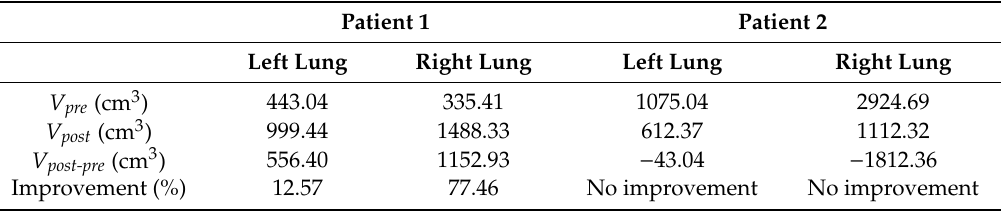
Figure 4. Perfusion SPECT images pre-treatment (left) and post-treatment (right). The contour of the segmentation is drawn in green in the images and the color bar. ( a ) Patient 1 (right lung). ( b ) Patient 2 (left lung). Table 6. Perfusion volumes before and after treatment for CTEPH.